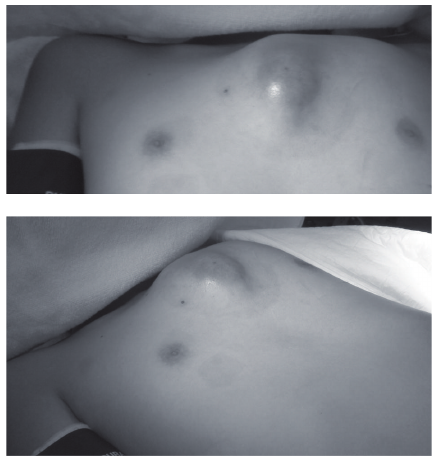
Figure 1: Photographs of the anterior chest region show extensive swelling.